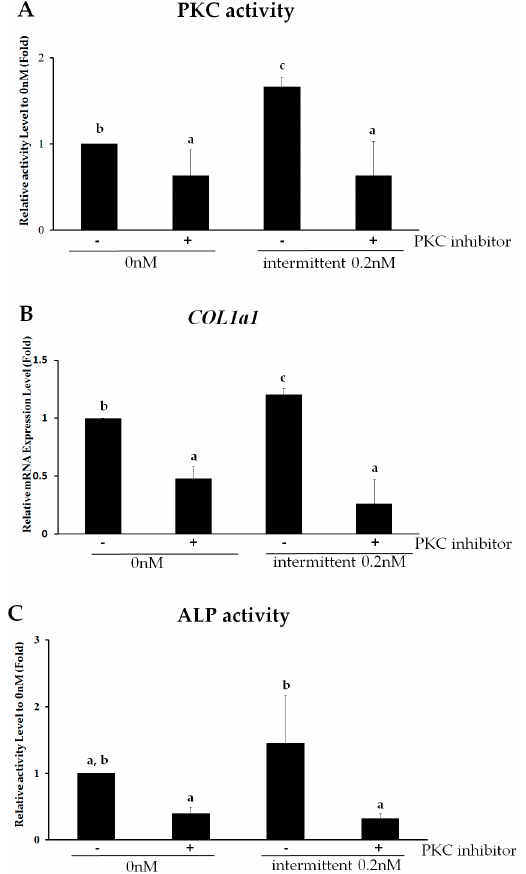
Figure 4. The PKC pathway is involved in intermittent parathyroid hormone (PTH) (1–34)-enhanced osteogenesis from human mesenchymal stem cells (hMSCs). ( A ) Protein kinase activity of PKC activity in hMSCs on day 7 of osteogenic differentiation after intermittent treatment with or without 0.2 nM of PTH (1–34) in the presence or absence of the broad-spectrum PKC inhibitor R136; ( B ) Relative mRNA expression of the osteoblast-specific gene COL1a1 in hMSCs after 0.2 nM intermittent PTH (1–34) treatment in the presence or absence of R136; ( C ) Alkaline phosphatase (ALP) activity in hMSC on day 7 of osteogenic differentiation treated intermittently with or without 0.2 nM of PTH (1–34) in the presence or absence of R136. The relative activity of each sample is reported as the ratio of ALP activity to the corresponding protein concentration (units/mg). Data are represented as mean ± SD ( n = 3). Statistical data analysis was performed by performing one-way ANOVA with Tukey’s post-hoc tests. Different letters represent significant differences between groups; those with the same letters were not significant ( p < 0.05).